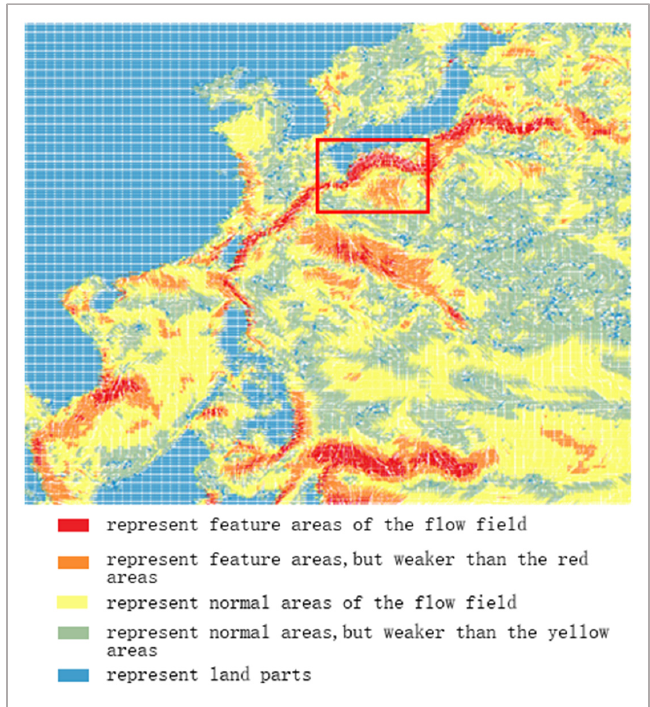
Figure 6. The areas where the color is red or orange are the feature areas of the flow field data. While the blue areas indicate the land parts, and the yellow areas stand for the place where the flow field features are not obvious. Besides, the red frame selected area is the place where the rendering effects are compared in Section 3.1.3.